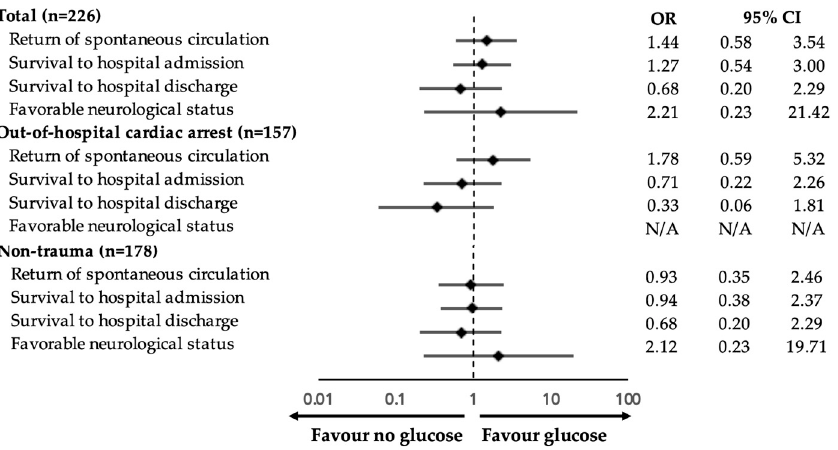
Figure 3. Weighted multivariable logistic regression analysis of each outcome in three different models, stratified by the location and mechanism of cardiac arrest. CI, confidence interval; OR, odds ratio.